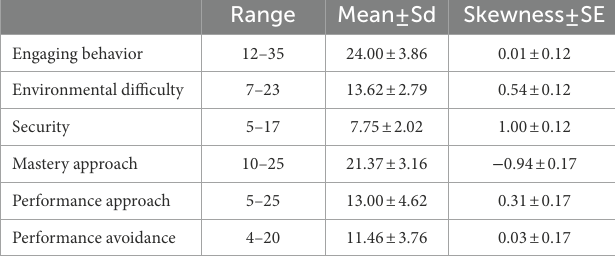
TABLE 4 Descriptive statistics for hypothesis two, study variables.